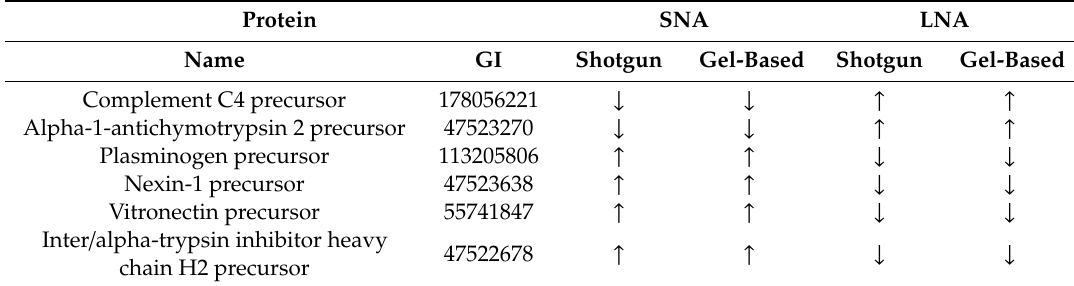
Figure 4. Two dimension-differential in gel electrophoresis (2D-DIGE) of protein in SNA (green spots) and LNA (red spots) samples. Table 4. Examples of dysregulated proteins detected with both shotgun and gel-based